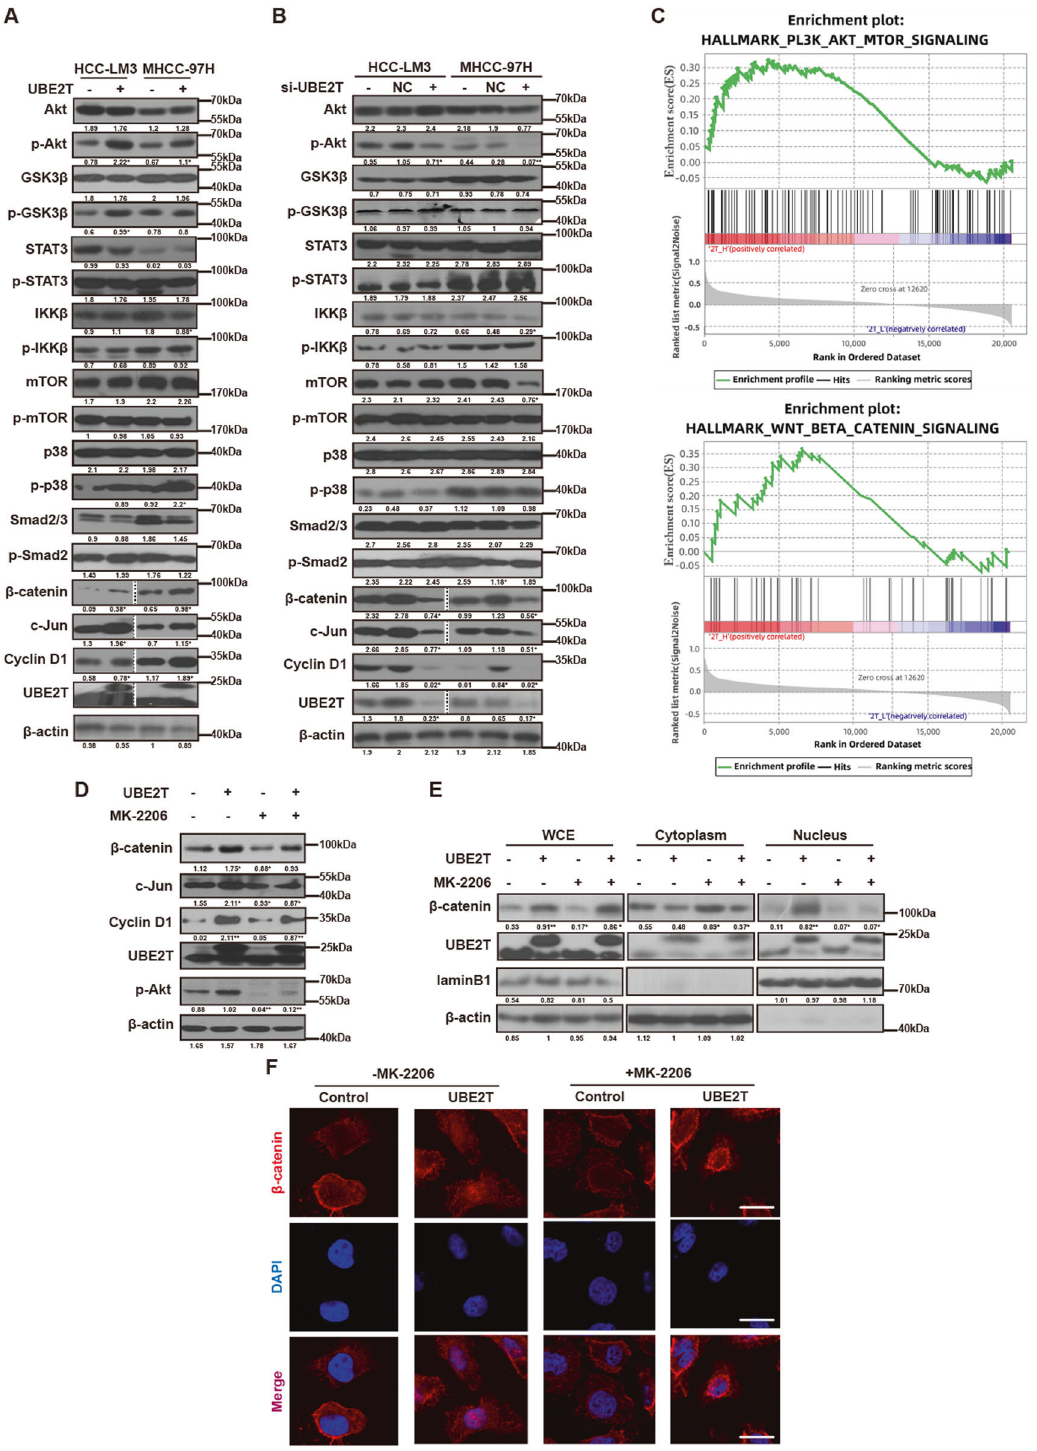
Fig. 5 UBE2T activates the Akt/ β -catenin signaling pathway. A , B WB was used to assess the key factors in several signaling pathways in A UBE2T-overexpressing and control, B UBE2T-silencing and control HCC-LM3/MHCC-97H cells. C GSEA exhibited the correlation between the expression of UBE2T and gene signatures of the Akt/ β -catenin signaling pathway in the TCGA cohort. D UBE2T-overexpressing and control HCC-LM3 were treated with or without MK-2206 (50 μ M, 48 h). Total cells lysate were detected for the indicated proteins. E cells were treated as ( D ) and then collected for subcellular protein extraction, followed by WB to detect β -catenin and p-Akt. F Cells were treated as panel ( D ). Representative images of immuno fl uorescence staining for β -catenin (Red) are shown. Scale bar = 200 μ m. The average gray values and the statistical data were shown under the corresponding band. Student ’ s t -test was used for comparisons, * P < 0.05, ** P < 0.01.